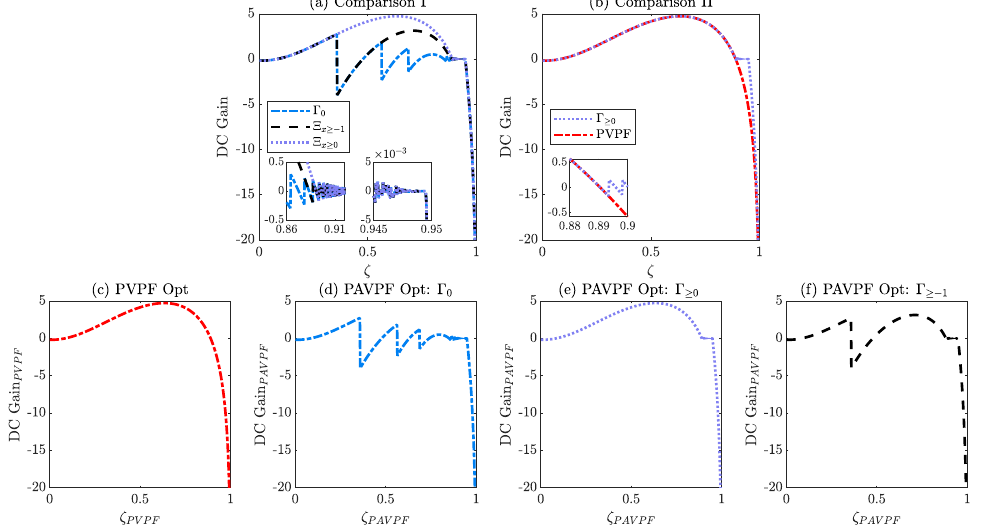
Figure 6. ( c – f ) shows the individual behaviour of three different PAVPF optimisation schemes, as well as using a PVPF optimisation curve as a baseline. ( a , b ) show important comparisons that infer important results about PAVPF’s behaviour when subject to how it is defined in Equation